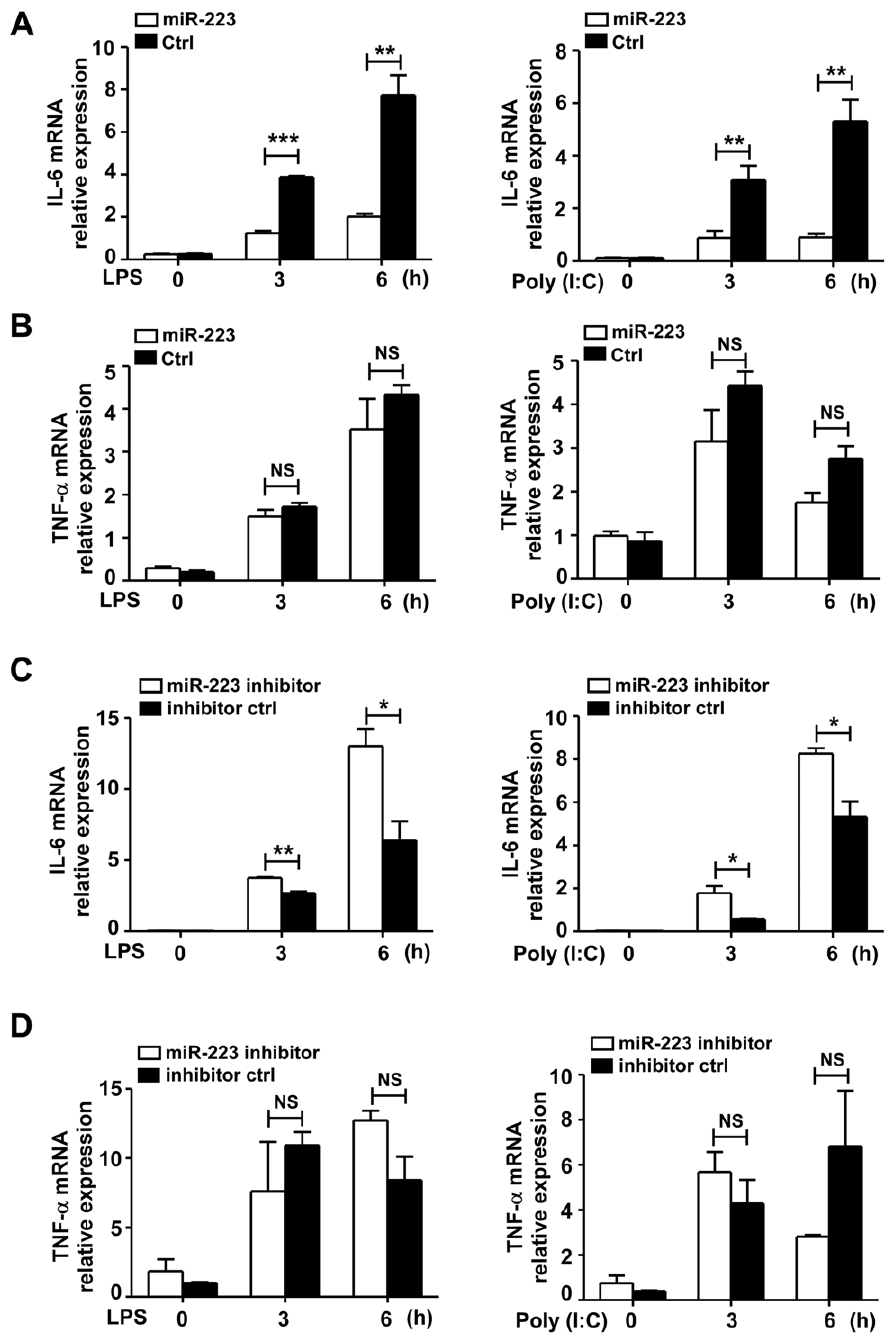
Figure 2. MiR-223 inhibits IL-6 mRNA expression but not TNF- a , in TLR-triggered macrophages. RAW264.7 cells were transfected with mimics or inhibitors of miR-223 and their controls at a final concentration of 30 nM. 24 h later, cells were stimulated with or without LPS (100 ng/ml) or poly (I:C) (10 m g/ml). IL-6 (A, C) and TNF- a (B, D) mRNA levels were measured at 3 h and 6 h post-stimulation by qPCR. Data are the mean 6 SD (n=3) of three independent experiments. *** p , 0.001; ** p , 0.01; * p , 0.05; NS, not